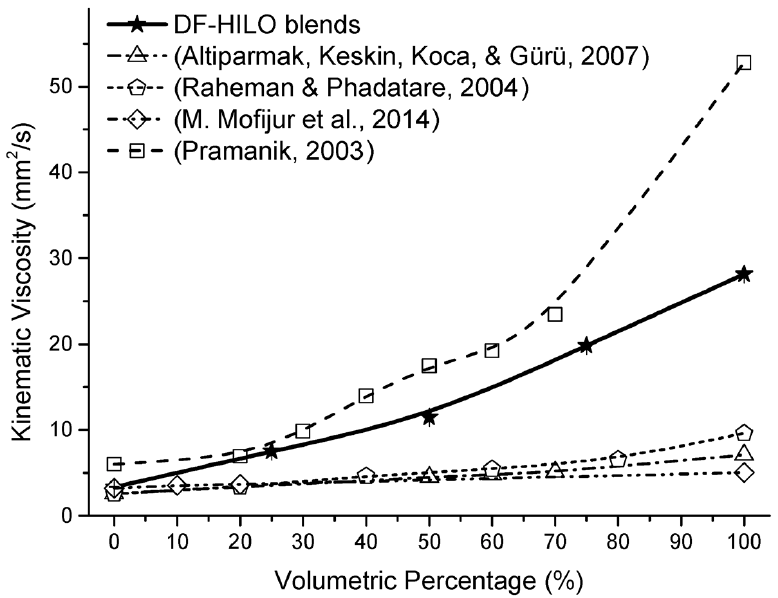
Figure 6. Kinematic viscosity vs. volumetric percentage [47,48,50,53]. The heating value curves against the different concentrations of biofuel are presented significantly with the addition of HILO. This behavior is a result of the lower heating value of HILO compared to diesel fuel. Additionally, the heating value of the fuel blends